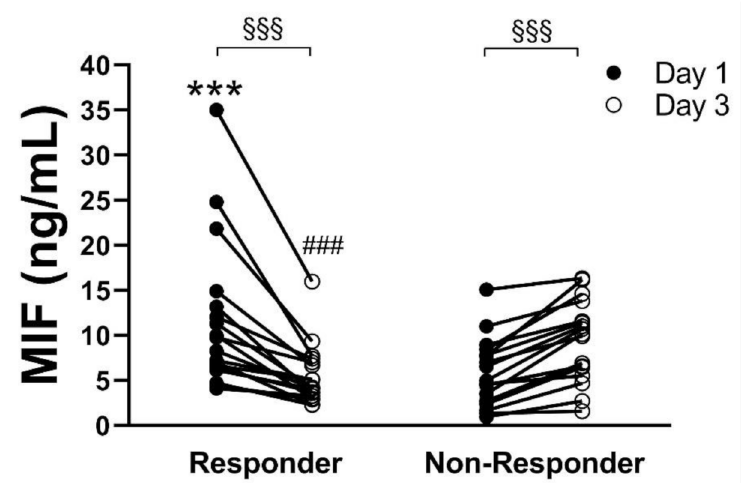
Figure 2. Plasma concentration of macrophage migration inhibitory factor (MIF) on day 1 (black circles) and day 3 (white circles) of intensive care unit (ICU) admission for each of the 36 coronavirus disease 2019 (COVID-19) patients. Patients showing decreasing MIF concentrations between day 1 and day 3 were summarized as “Responder” and those with increasing MIF concentrations were summarized as “Non-Responder” *** p < 0.001 vs. day 1 Non-Responder; ### p < 0.001 vs. day 3 Non-Responder; §§§ p < 0.001 day 1 vs. day 3.